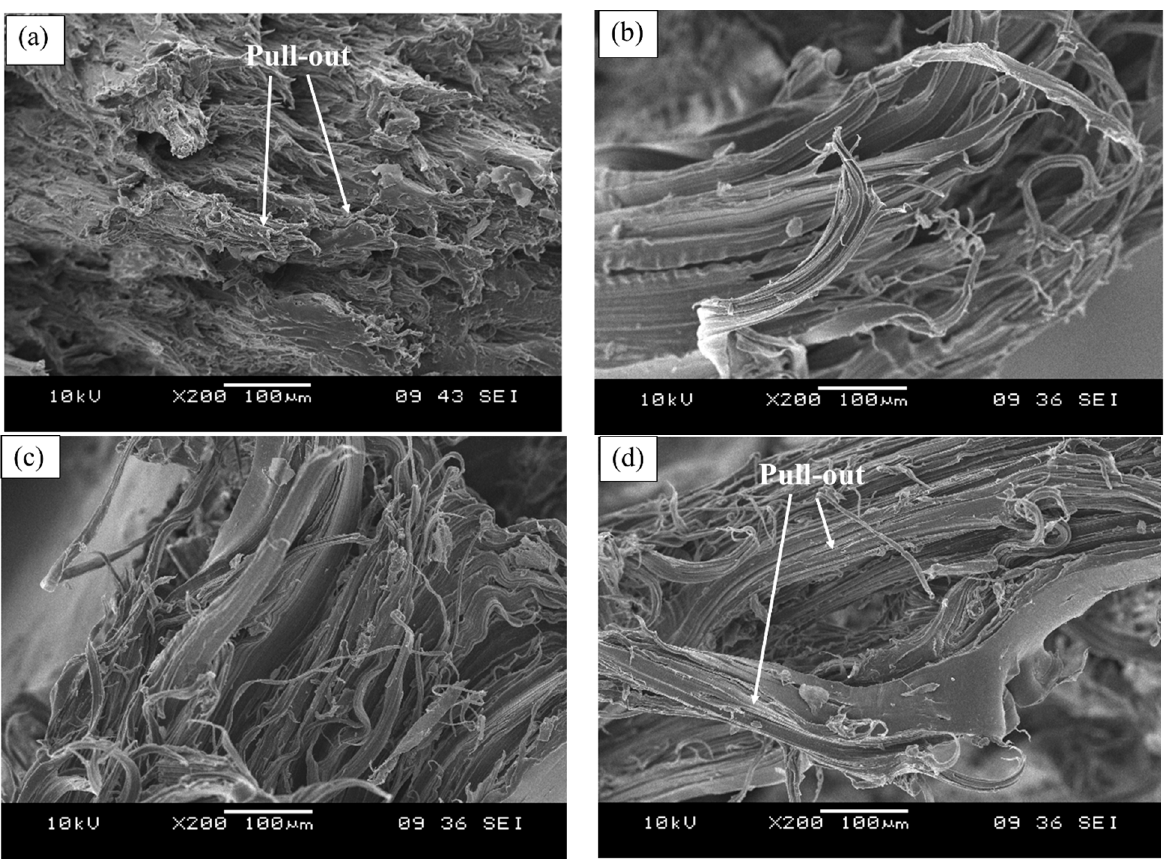
Figure 3. Tensile fractured surface of EVA/CWF composites containing different contents of ZnCl 2 : ( a ) 0, ( b ) 2 wt%, ( c ) 6 wt%, and ( d ) 8 wt%.